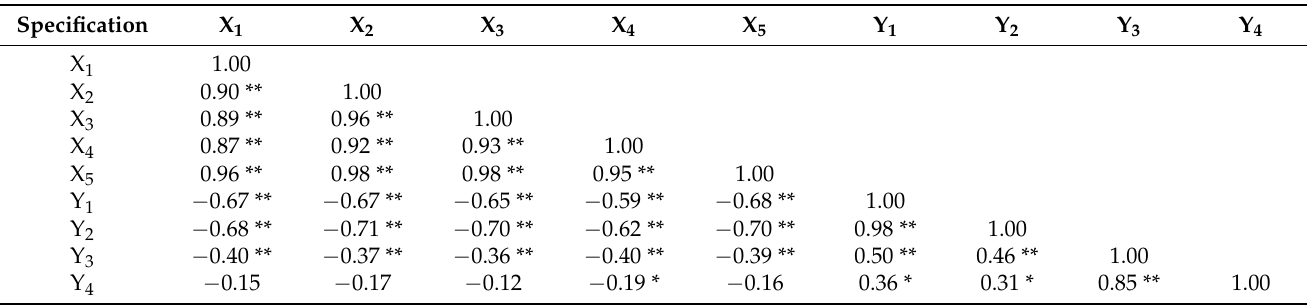
Table 5. Simple Pearson’s correlation coefficients between the rate of spread of potato blight and the yield of